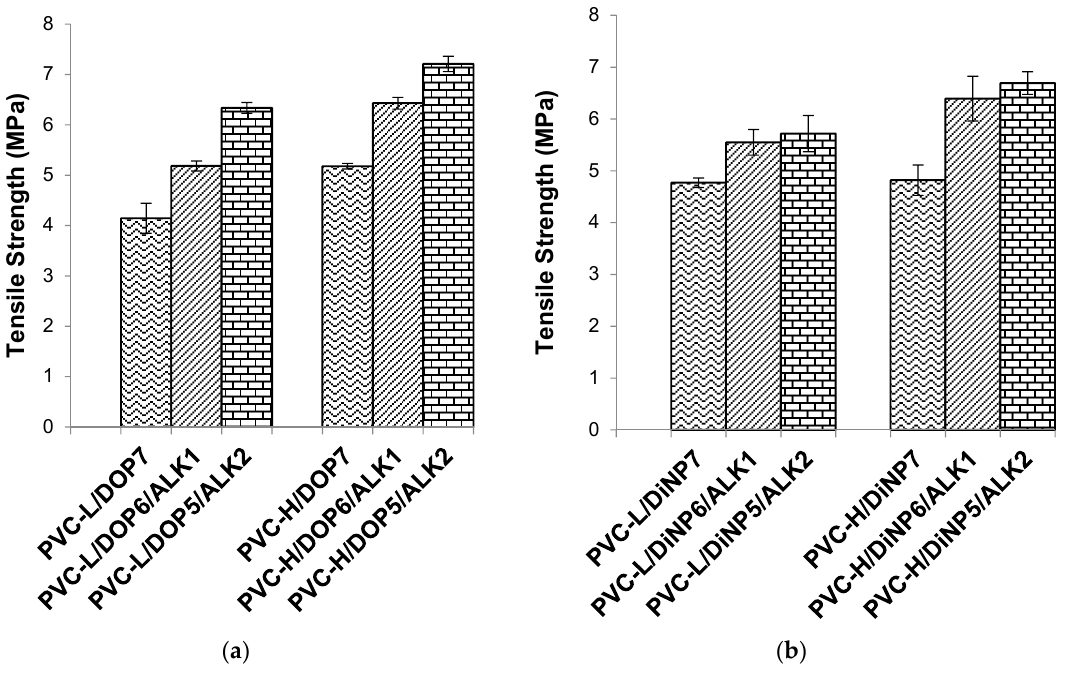
Figure 3. Effect of palm oil-based alkyd on the tensile strength of ( a ) PVC/DOP blend and ( b ) PVC/DiNP blend.